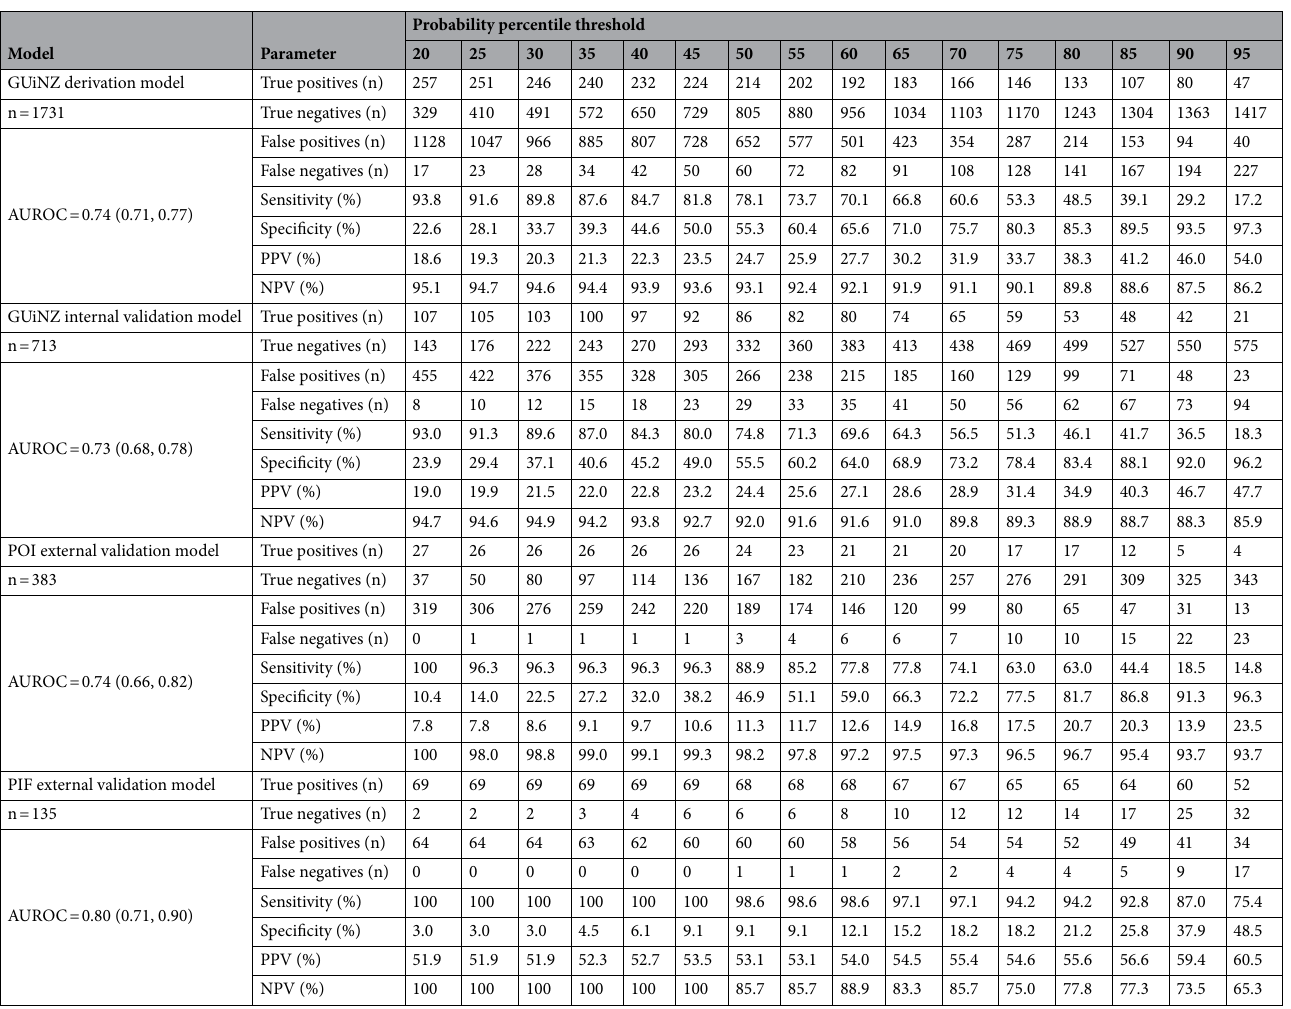
Table 3. Accuracy and predictive capacity of a prediction model for childhood obesity for New Zealand among the derivation and validation cohorts. AUROC area under the receiver operating characteristic curve, GUiNZ Growing Up in New Zealand Study, NPV negative predictive value, PIF Pacific Islands Families Study, POI Prevention of Overweight in Infancy Study, PPV positive predictive